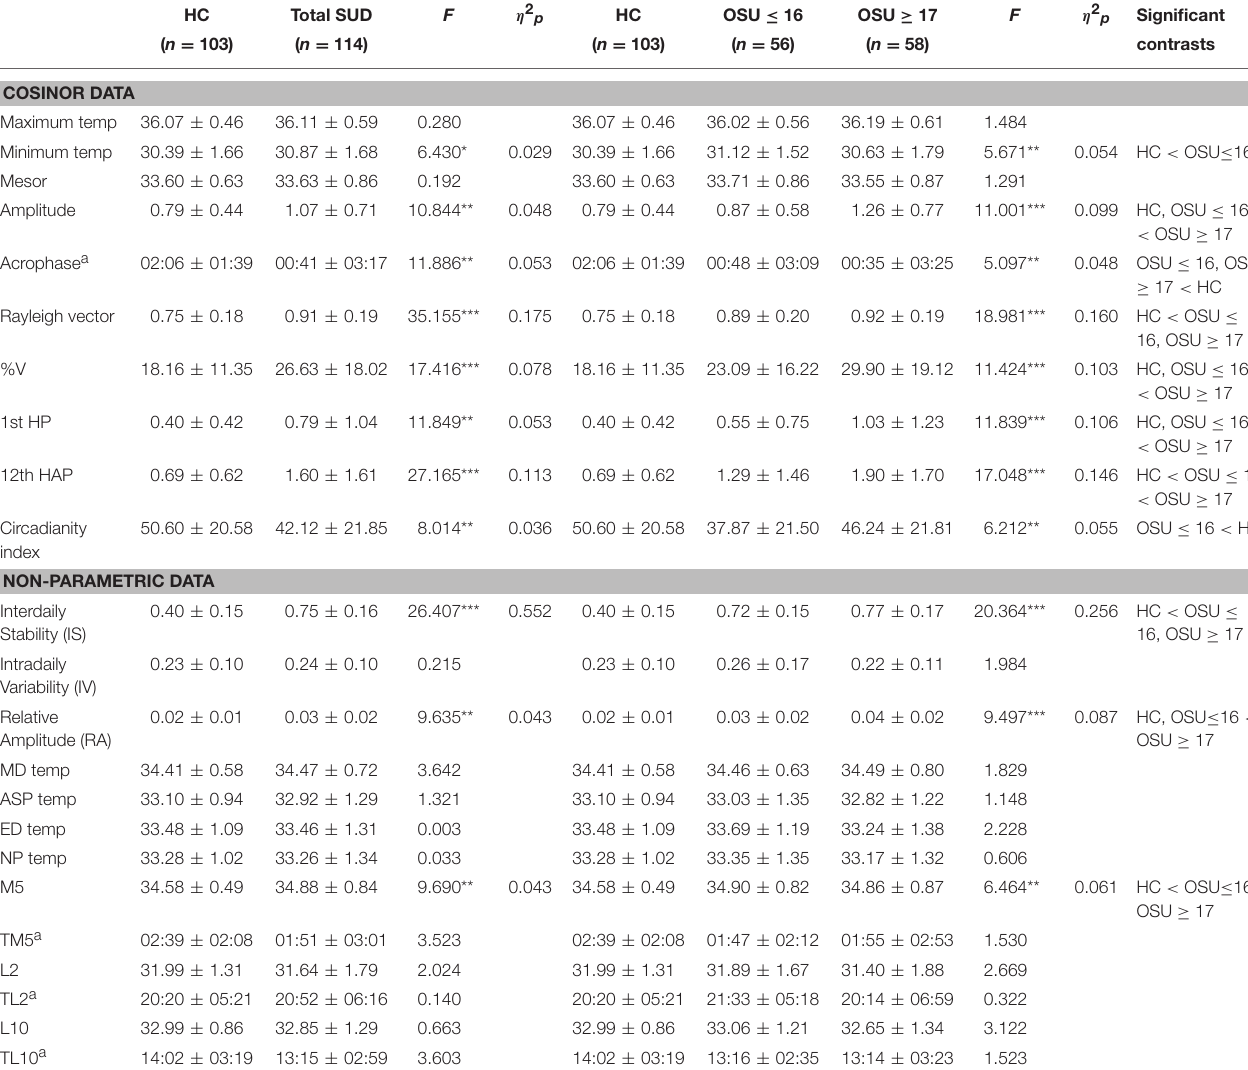
TABLE 4 | Distal skin rhythmic variables for the HC, SUD and age of OSU